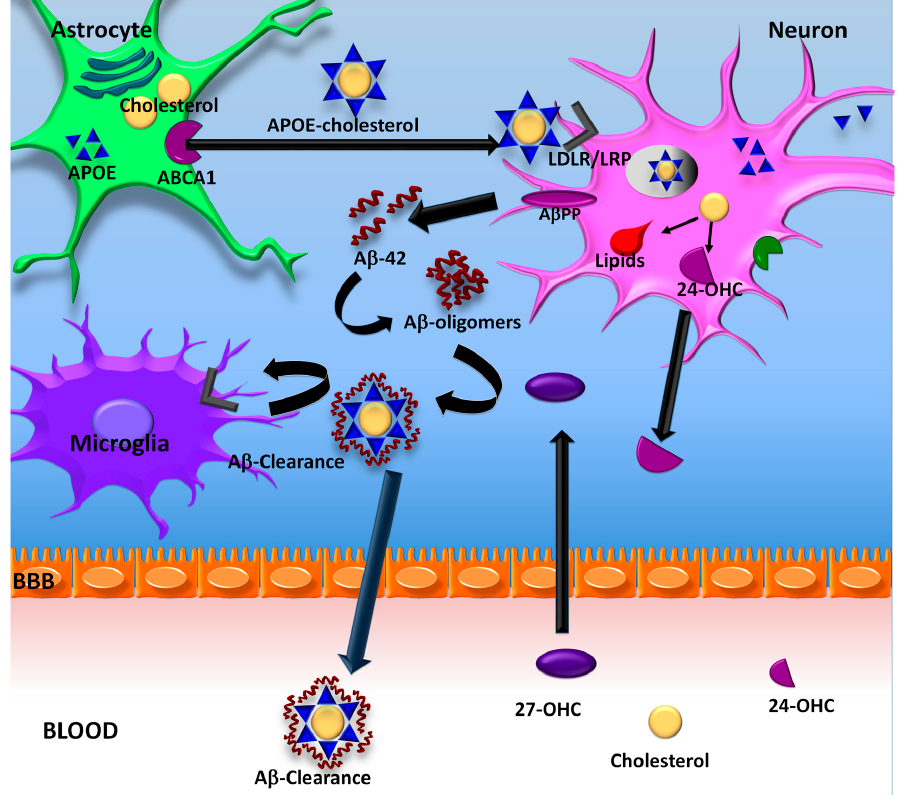
Figure 1. Cholesterol and A β clearance. Cholesterol is produced in the endoplasmic reticulum (ER) of astrocytes. Once synthesized, it binds to APOE, to be transported to the outside of the cell through ABCA1. Cholesterol-APOE complexes are internalized into neurons with the help of LDLR/LRP receptors. Altered cholesterol metabolism induces an increase in A β PP processing, leading to the release of A β peptides, which aggregate in oligomeric forms in the presence of lipids. Amyloid can be removed by specialized proteases within the CNS or peripherally by forming complexes with APOE-cholesterol .